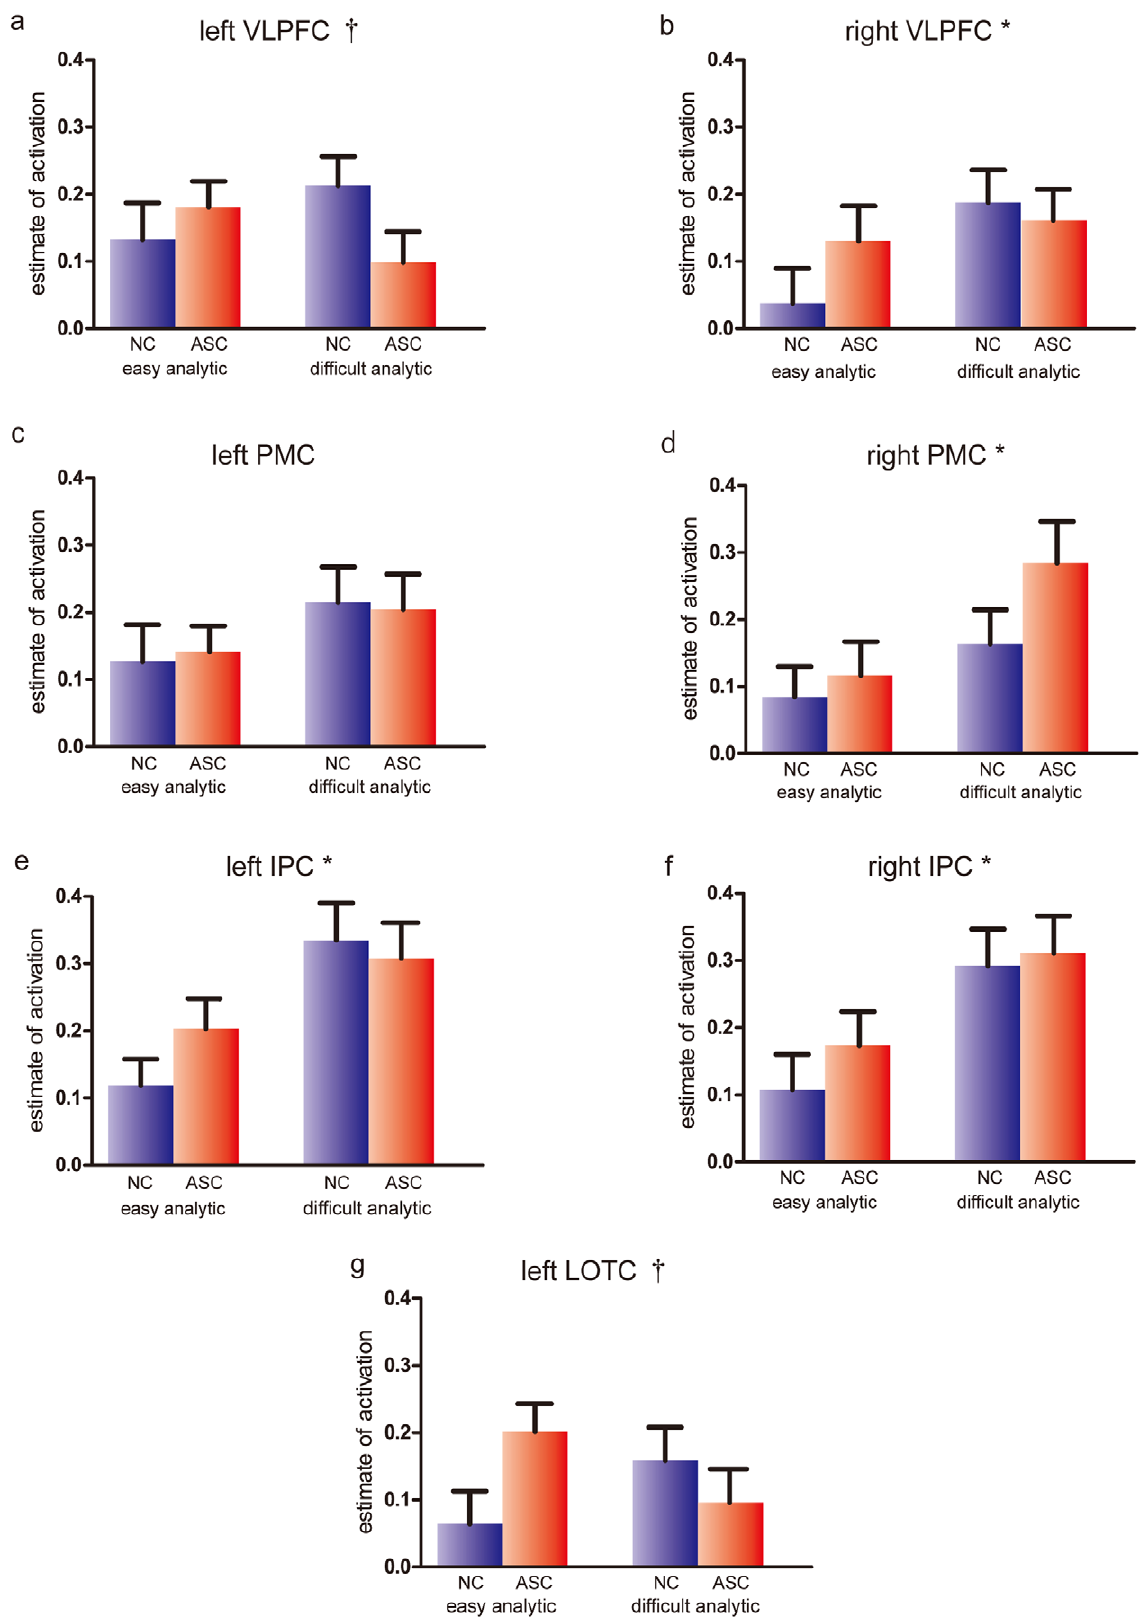
Figure 4. Region of interest (ROI) analysis of activation during the two analytic conditions. (a) Left ventrolateral prefrontal cortex (VLPFC),